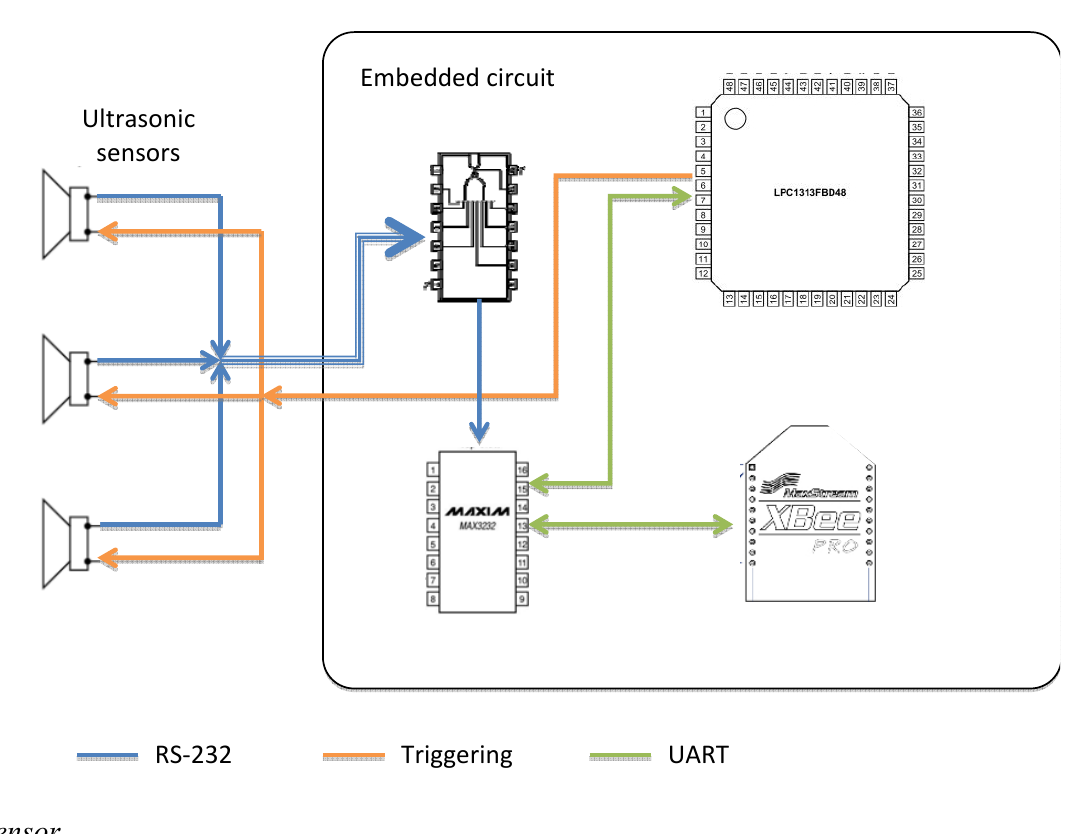
Figure 1. Connection of the major components of the embedded circuit with the ultrasonic